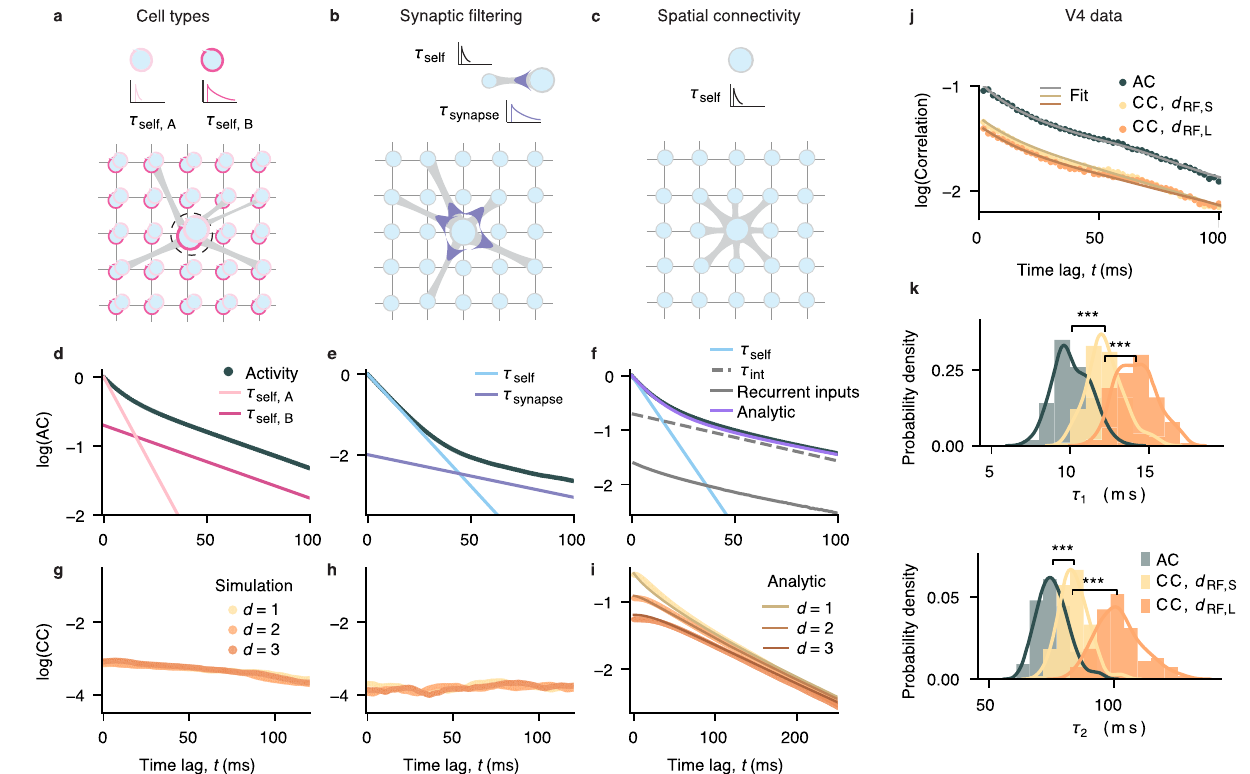
Fig. 5 | Mechanisms for generating multiple timescales in local population captured by the autocorrelation of recurrent inputs received by each unit in activity. a – c Network models consist of units (circles) arranged on a two- simulations (gray) and an analytical effective interaction timescale ( τ int , dashed dimensional lattice (thin grey lines). Each target unit (large circle) receives inputs line). g – i In the models with random connectivity, cross-correlations between the from 8 other units in the network (thick grey lines). The connectivity is random activityoflocalpopulationsdonotdependonthedistance( d )betweenunitsonthe ( a , b )orspatiallyarranged witheachunitconnectedtoitsnearest neighbors( c ).In lattice(twocelltypesin g ;synaptic fi lteringin h ).Incontrast,inthespatialnetwork themodelwithheterogeneouscelltypes( a ),alocalpopulationateachlatticenode model,cross-correlationsdependondistance d andexhibitmultipletimescales( i ). (dashed circle) consists of two cell types, A and B, with distinct timescales (self- The strength of cross-correlations decreases with distance, and slower interaction excitation probabilities p s,A =0.88 and p s,B =0.976). In the model with two local timescales dominate cross-correlations at longer distances. For all models: BP= biophysicalprocesses( b ),eachlocalpopulationhasafastmembranetimeconstant 0.99, p ext =10 − 4 . j Auto- and cross-correlations of V4 spiking activity recorded on different channels overlaid with correlations of synthetic data with MAP para- (modeled as p s =0.88) and a slow synaptic time constant (modeled as τ synapse =41 meters (data from monkey G, FT; data from monkey N in Supplementary Fig. 9). ms). The spatial network model ( c ) assumes only a single self-excitation timescale The strength of cross-correlations is smaller than the auto-correlation and ( p s =0.88) for each unit. d – f All models reproduce two distinct timescales in the autocorrelations of local population activity. In the model with two cell types ( d ), decreases with RF-center distance ( d RF,L > d RF,S ). k Posterior distributions of time- thetimescalescorrespondtotheself-excitationtimescalesoftwounittypes( τ self,A , scales from fi tting correlations in j . Cross-correlations had slower timescales than fi ltering( e ),thetimescalescorrespond τ the autocorrelation, and slower timescales dominated cross-correlations at larger self,B ,pinklines).Inthemodelwithsynaptic totheself-excitationandsynaptictimescales( τ self , τ synapse ,bluelines).Inthespatial RF-center distances. Statistics: two-sided Wilcoxon rank-sum test, *** indicate p <10 − 10 . Number of samples in each posterior N =100. Correlations are plotted network model ( f ), the unit ’ s autocorrelation exhibits multiple timescales and is well captured by the analytical derivation (purple). The fast autocorrelation decay from the fi rst time-lag ( t =2 ms). Source data are provided as a Source Data fi corresponds to the self-excitation timescale ( τ self , blue). The slower decay is